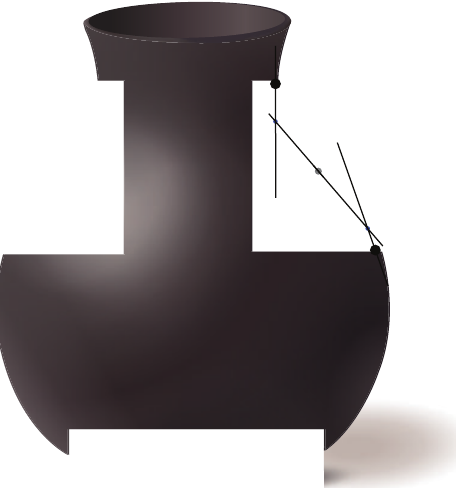
Figure 4: The input for S-shape completion